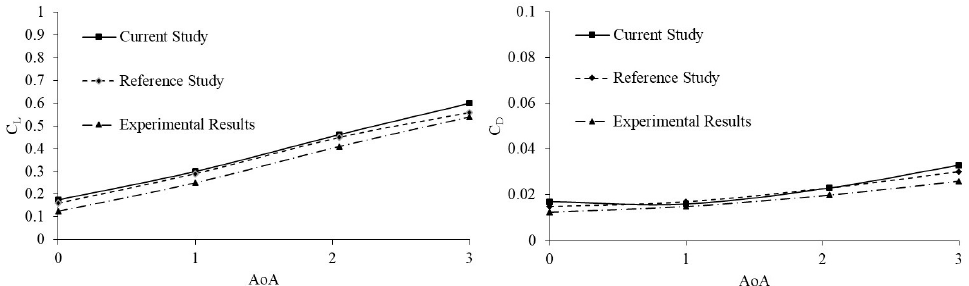
Figure 8. CRM aircraft in cruise flight condition S 1 (M = 0.85 at 44,000 ft) with various angle-of-attack ( α ~ 0° to 3°). Lift ( left ) and drag ( right ) coefficients obtained through the present CFD (line), with comparison against the reference CFD (dash) and experiment (dot-dash).